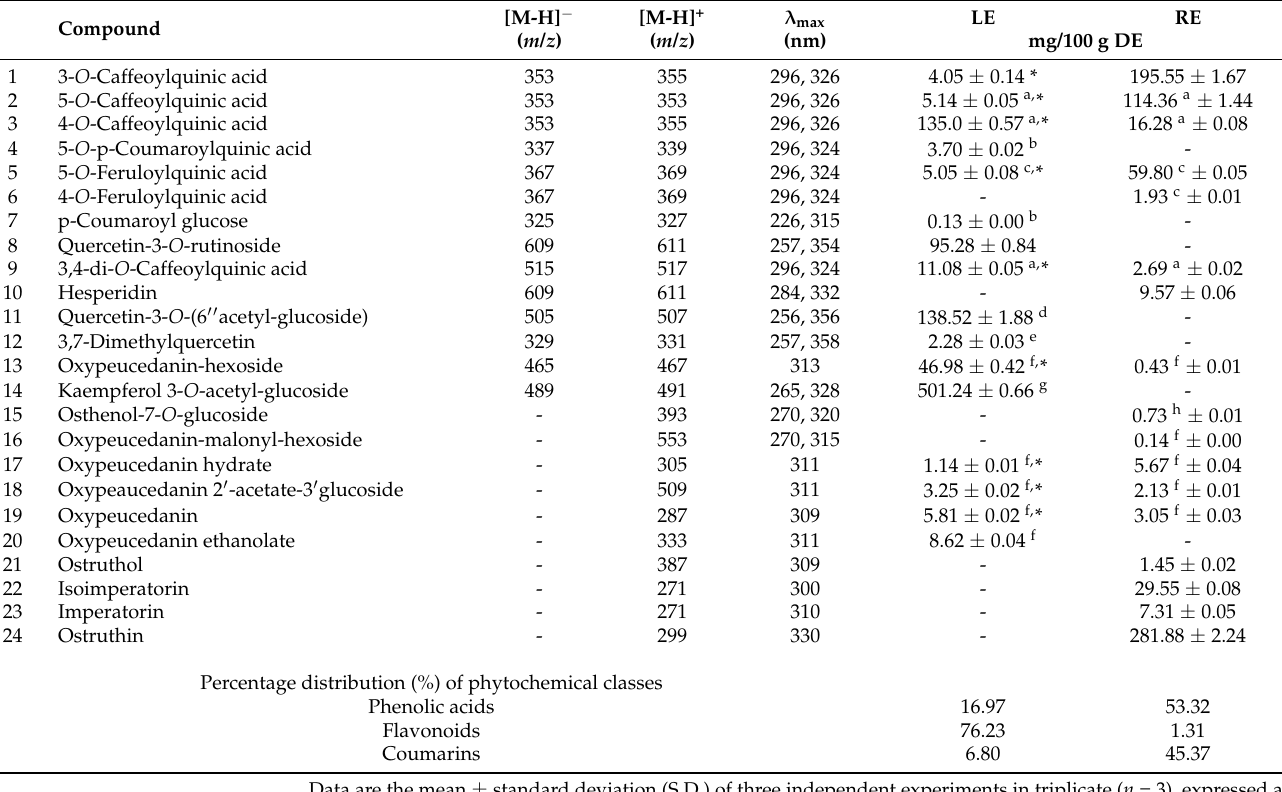
Table 2. Major components identified and quantified in P. ostruthium LE and RE by LC-DAD-ESI-MS